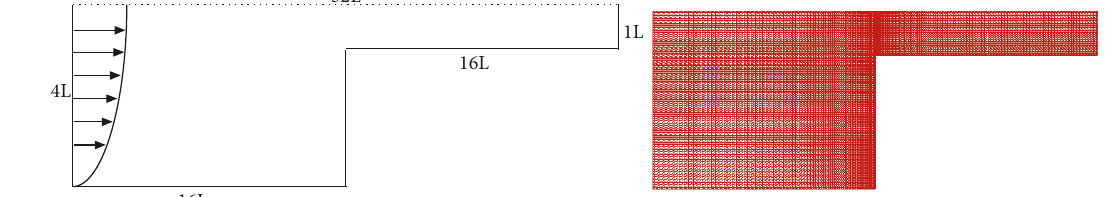
Figure 1: The 4: 1 planar contraction flow geometry and computational mesh.